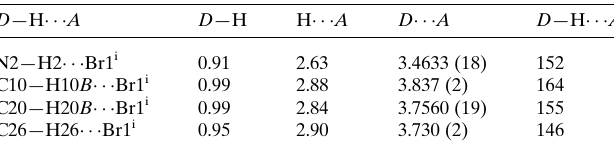
Table 1 Hydrogen-bond geometry (A˚ , (cid:4) ).